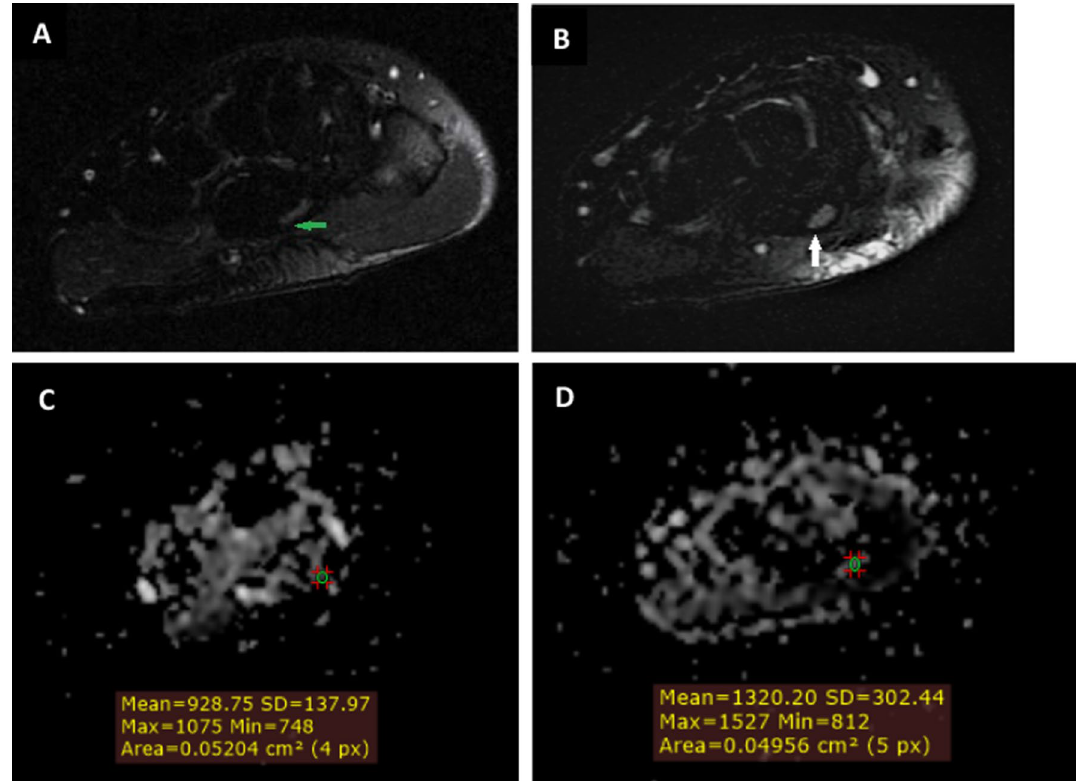
Fig. 3 A–D images: A 38-year-old female patient complained of left hand pain, tingling, numbness mainly at the thumb, index, middle finger, and radial half of the ring finger, and weakness of thumb abduction with history of wrist trauma 4 months ago. By nerve conduction studies, the case was diagnosed as severe carpal tunnel syndrome. A , B Axial T2SPAIR images showing increased signal intensity and flattening of the examined median nerve (green arrow) as well as bowing of the flexor retinaculum (white arrow), C ADC map showing low mean ADC value of MN at DRUJ (0.92 10 –3 mm 2 /s), and D ADC map showing increase of mean ADC value at pisiform (1.32 × consistent with carpal tunnel syndrome